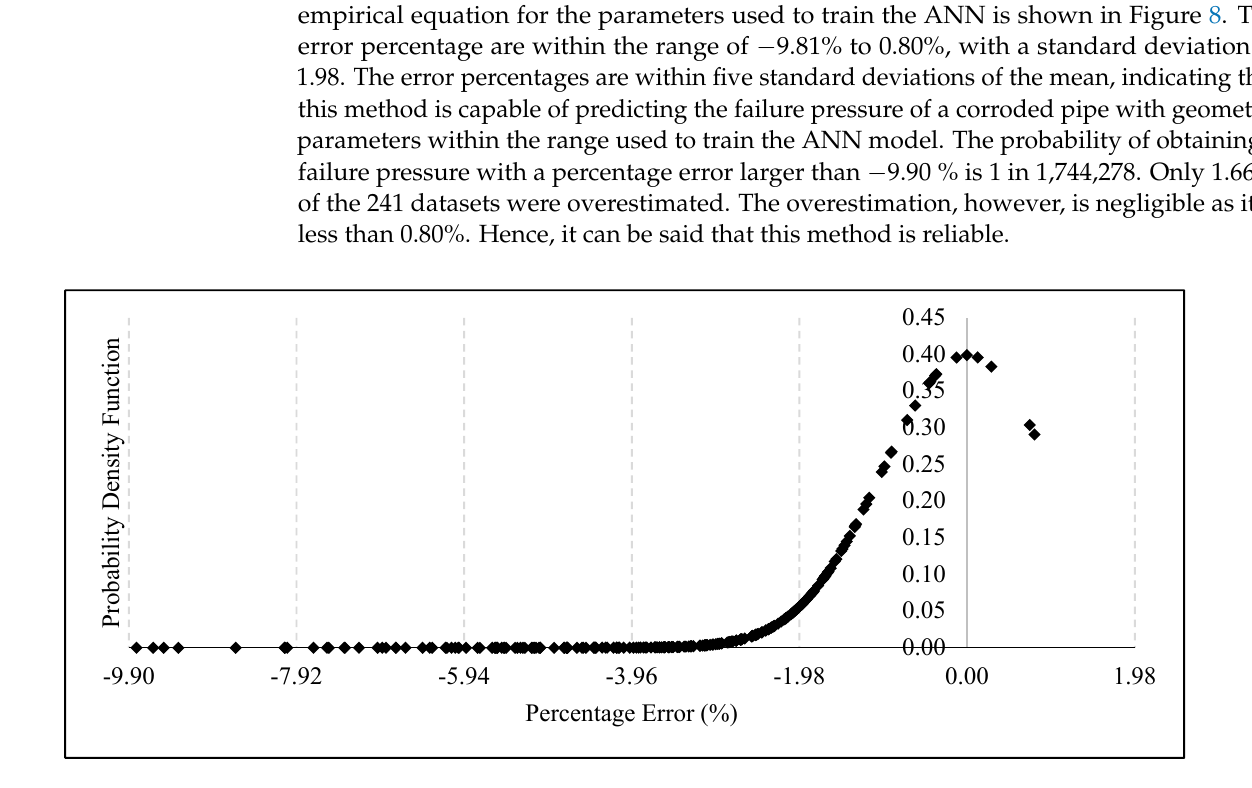
Table 13. Comparison of the failure pressure obtained using FEM and the empirical equation.